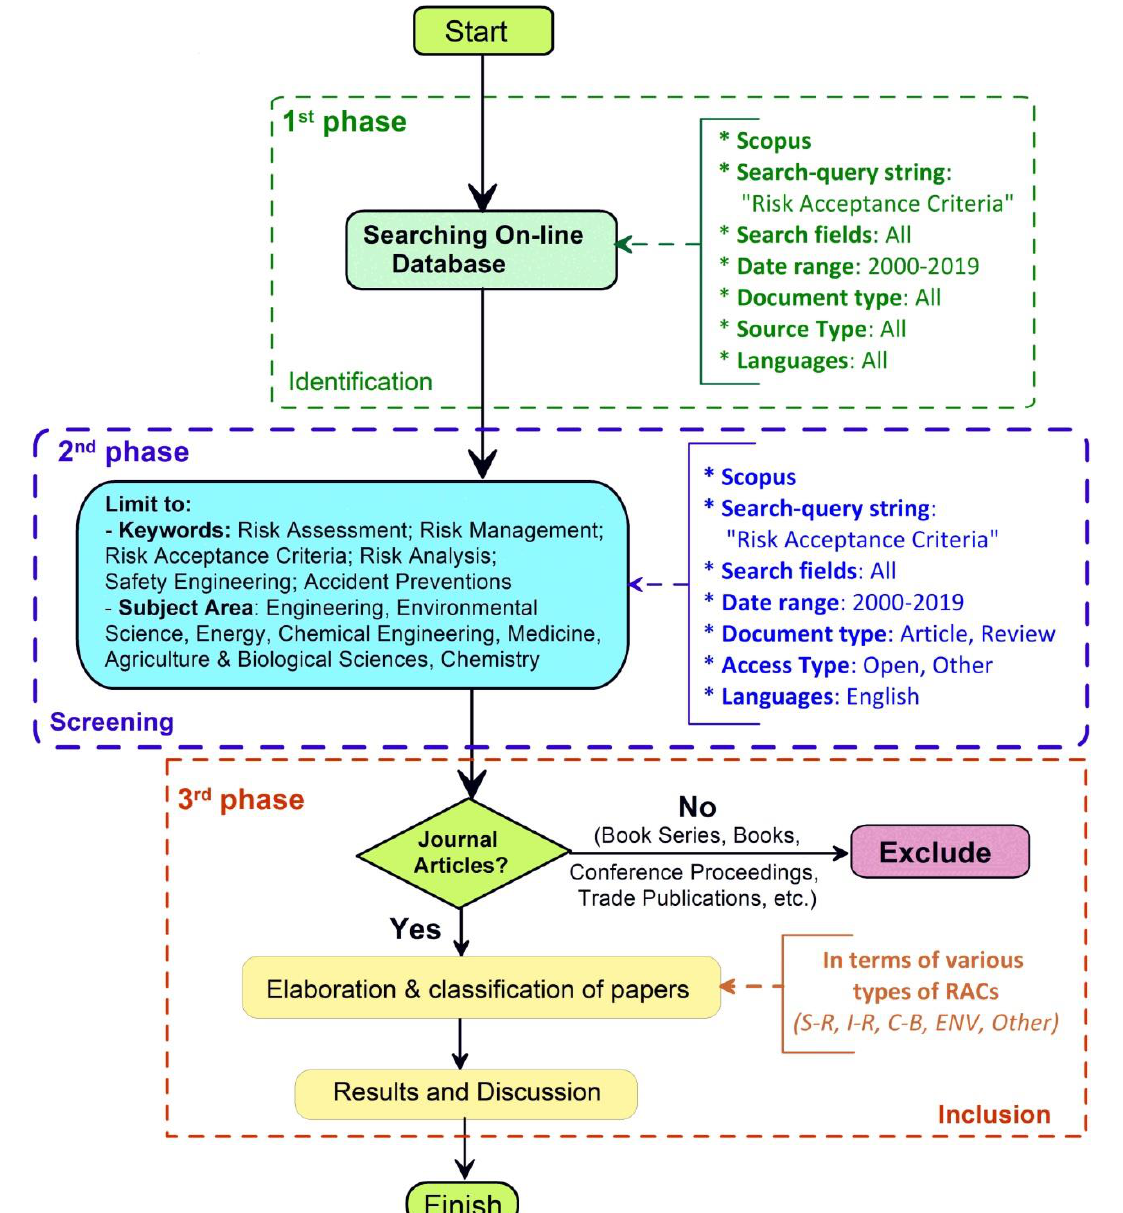
Figure 8. The flow chart of the utilized research methodology (compatible with PRISMA-2020 flow diagram for new systematic reviews).